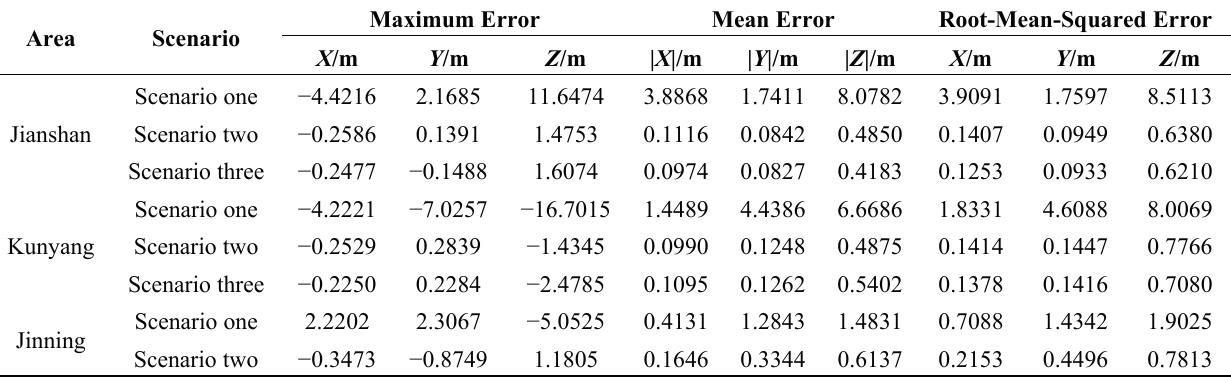
Table 5. Results of the geo-positioning accuracy with bundle block